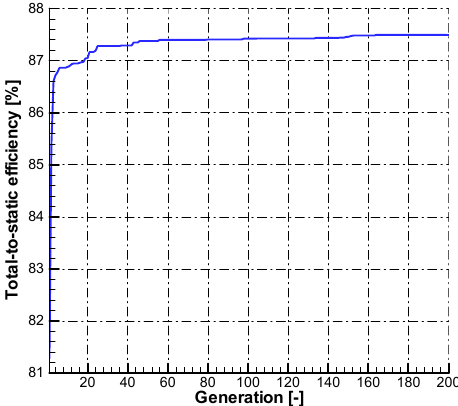
Figure 6. Convergence curve of the optimal design.